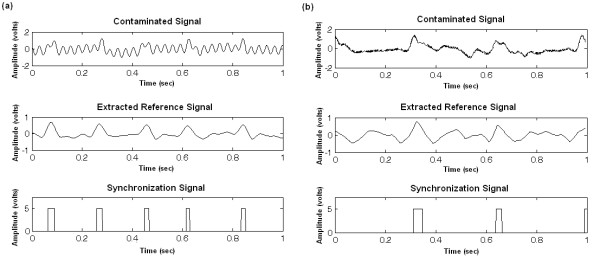
QRS detection on contaminated rodent ECG. (a) Mouse ECG recorded during an IRSE sequence and processed with coif3. Despite the low SNR and the very large base line drift, the algorithm succeeded in ensuring a perfect QRS detection. (b) ECG of a hypertensive rat with bundle branch block beat recorded during a FSE sequence, where one can clearly depict the effect of the pathology on the QRS morphology. After processing with the sym4 wavelet, the QRS are very well marked in the extracted reference signal.